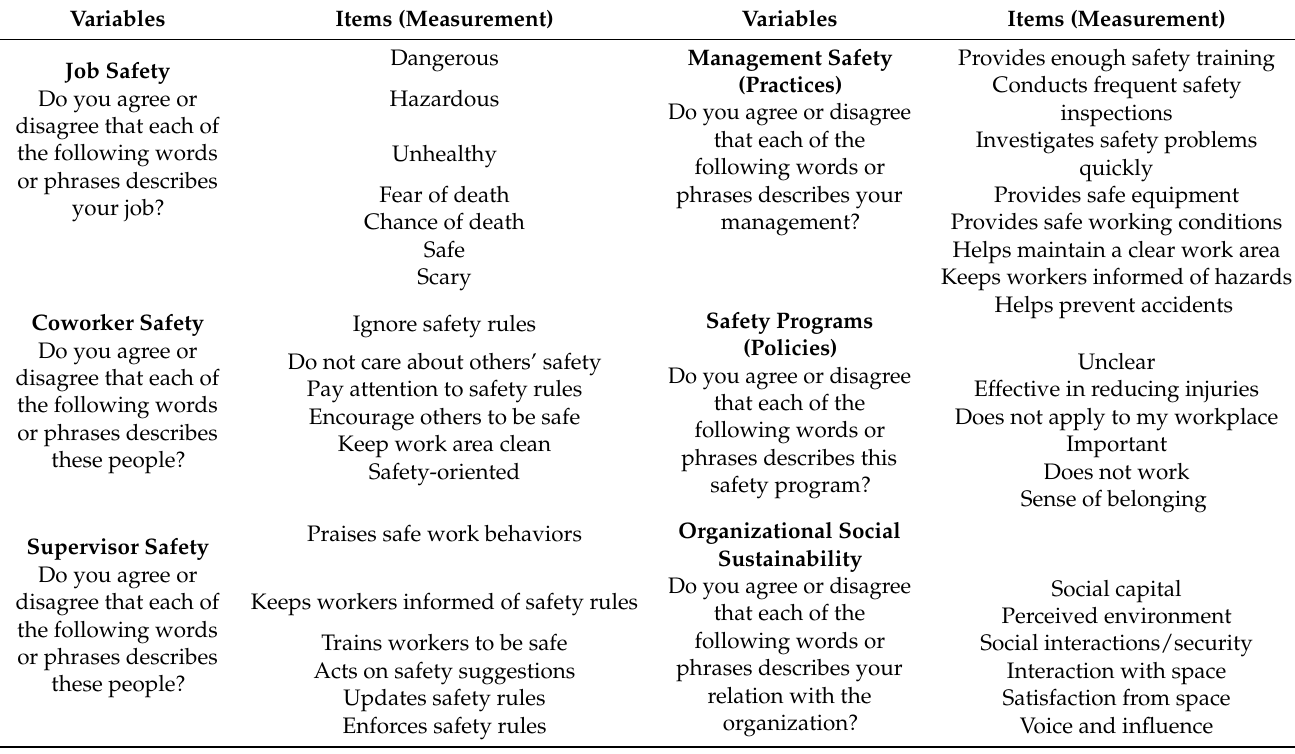
Table 1. The items measuring each variable of the